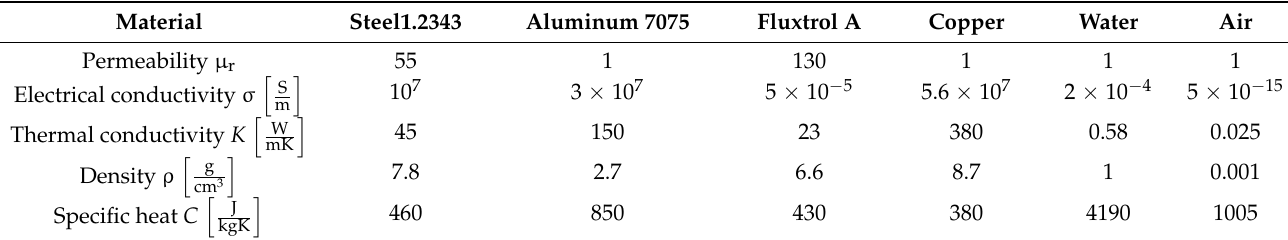
Table 1. Material properties used in the